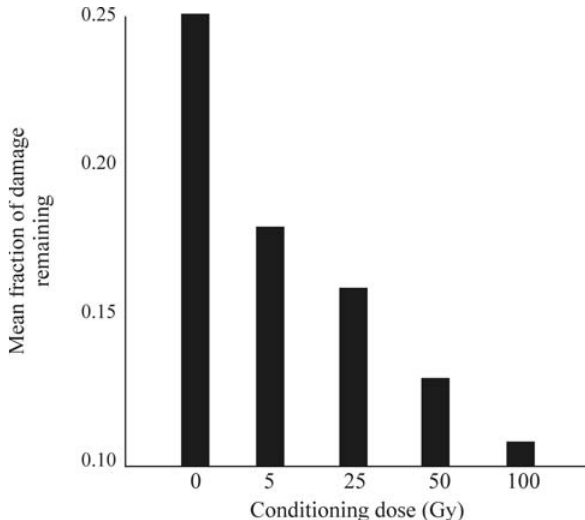
Figure 8 - The effect of increasing the magnitude of the conditioning dose on the fraction of DNA double-strand breaks remaining after a test dose of 500 Gy and four hours incubation in Chlamydomonas reinhardtii CW15. Error bars are not visible because the standard error is too small. Modified from Chankova and Bryant